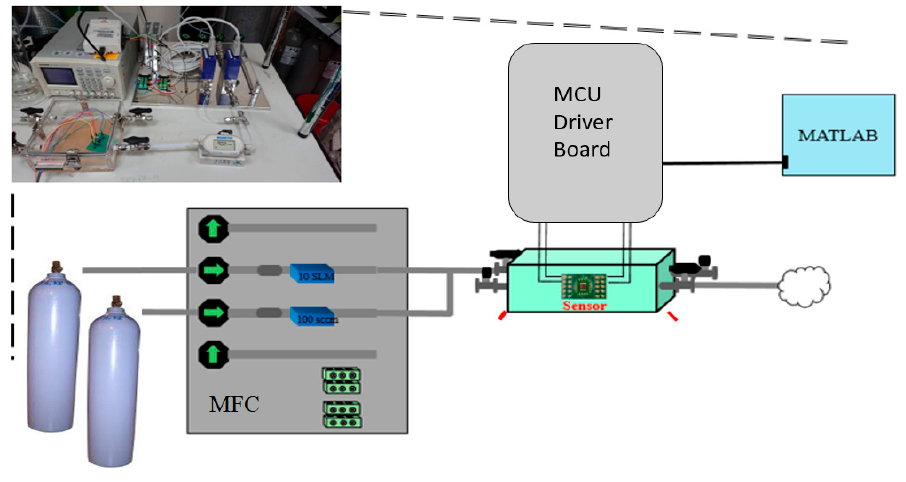
Figure 10. Photograph and schematic illustration of gas-detection test environment.